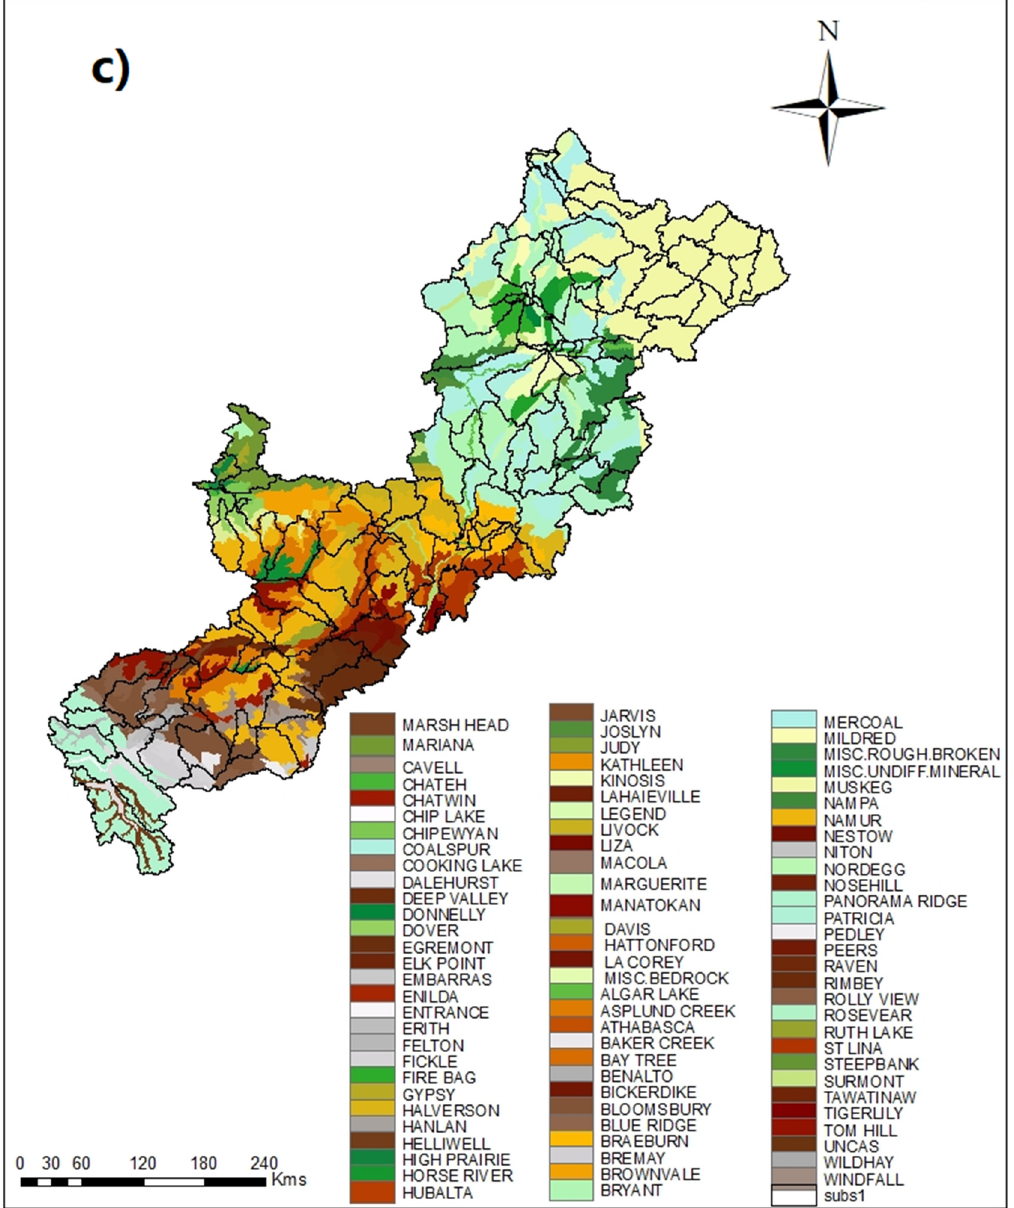
Figure 4. Model input: slope classification of Athabasca River Basin derived from DEM ( a ), and land-use/land-cover classification of Athabasca River Basin ( b ). Model input: soil maps of Athabasca River Basin ( c ). Table 1. SWAT land-use classification [18].